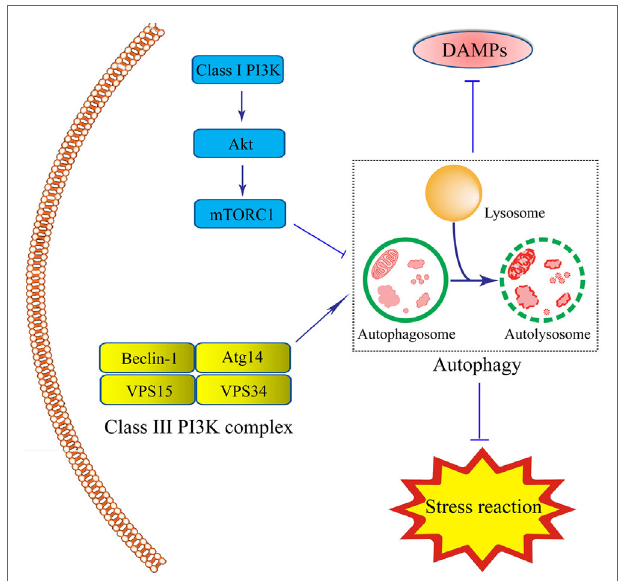
FigURe 1 | Schematic illustration of roles of intestinal epithelial cells (IEC) autophagy in the prevention of inflammatory bowel disease (IBD). Autophagy process in IECs is induced under inflammation- or immune-related challenge by the formation of the double-membrane autophagosomes. The integrity of autophagosomes and lysosomes leads to the formation of the single- membrane autolysosomes, functioning in degrading and recycling misfolded proteins, or dysfunctional organelles, thus contributing to cellular protection. The Class III-PI3K-Beclin-1 signaling pathway, led to the formation of Class III complex (Beclin-1-Atg14-vacuolar protein sorting(VPS)15-VPS34 complex) is the major inductive pathway to autophagy process, while the Class I-PI3K-mammalian target of rapamycin signaling pathway led to the inhibitory effects on autophagy process. The induction of autophagy protects IECs under stress through the degradation of various kinds of the damage- associated molecular pattern molecules and suppression of stress